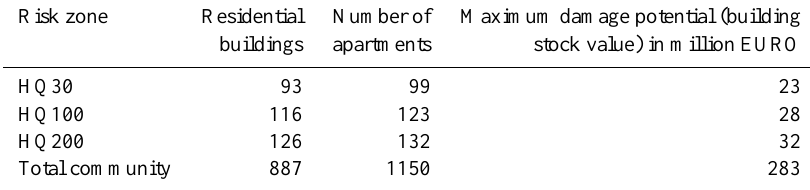
Table 2. Residential buildings in the risk zones and their market value in the case study area (D¨urnkrut in Lower Austria). Risk zone Residential Number of Maximum damage potential (building